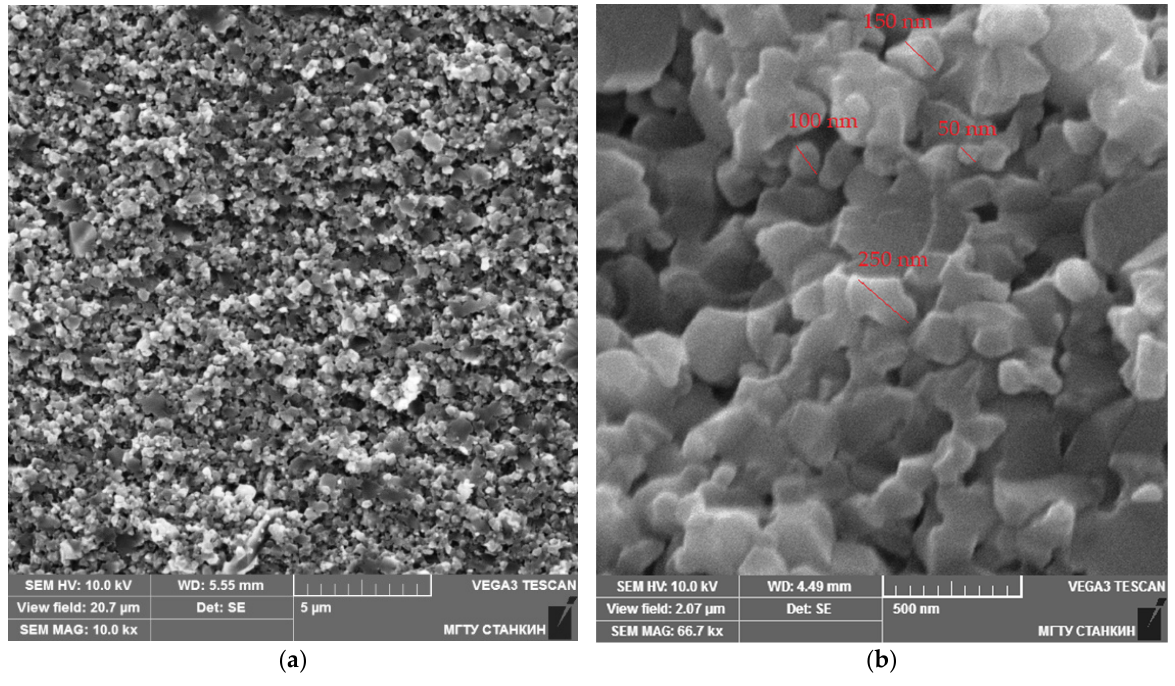
Figure 5. Microstructure of the Al 2 O 3 sintered sample at the fracture at 10,000× ( a ), at 66,700× ( b ). The chemical analysis of the sample (Table 8) at the fracture corresponded to the declared chemical composition of the powder without additional inclusions and impu- rities, which should have a positive effect on the physical and mechanical properties in volume. Table 8. Chemical analysis of Al 2 O 3 sample at the fracture. Chemical Elements